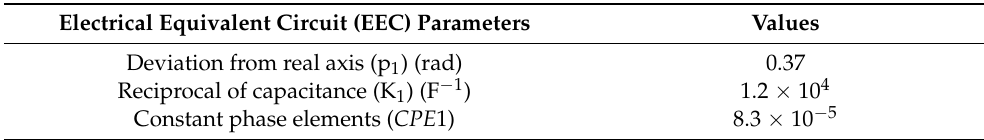
Table 1. Different circuit element parameters of the produced composite polymer electrolyte.